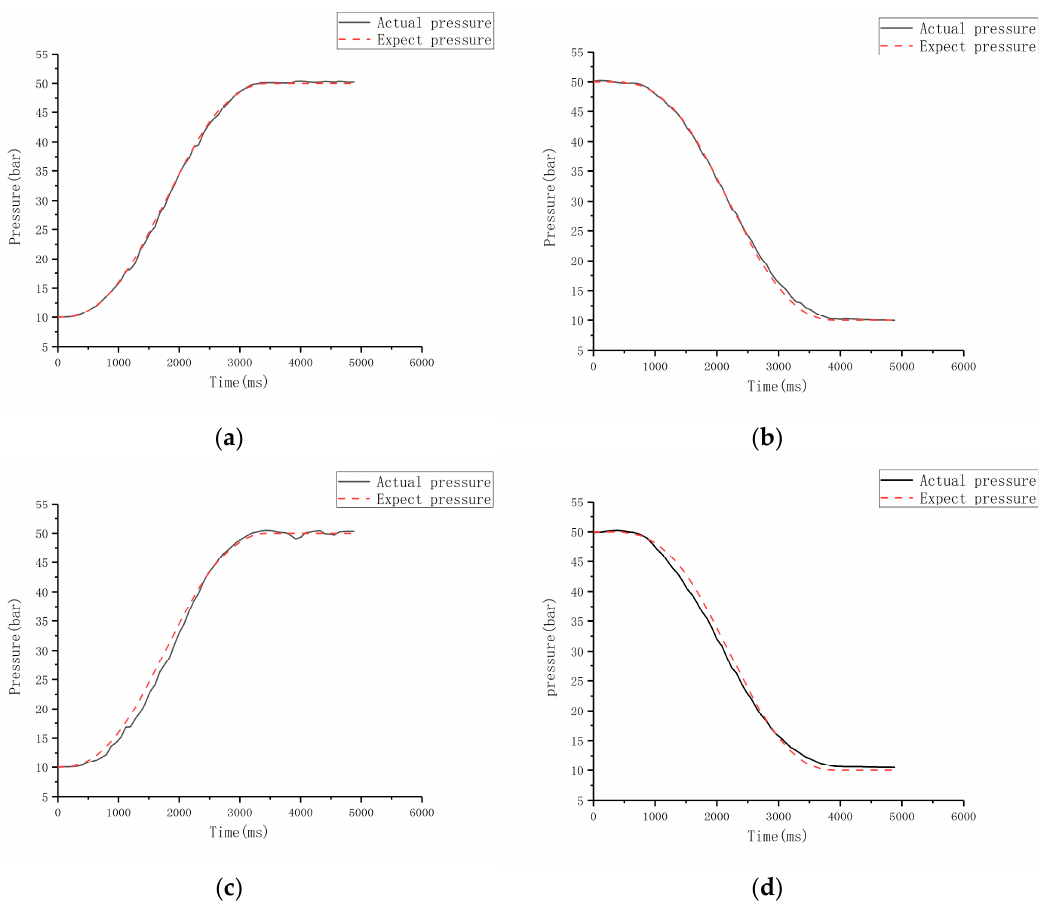
Figure 20. Pressure change curves when step signal changes from 10 bar to 50 bar and 50 bar to 10 bar. ( a ) Step rise curve of DTC based on sliding-mode control; ( b ) step descent curve of DTC based on sliding-mode control; ( c ) step rise pressure change curve of variable-speed pressure control; ( d ) variable-speed pressure control step-down pressure change curve.